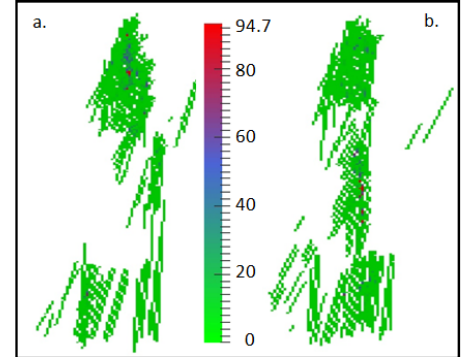
Figure 9. Two vertical slices of the voxel space coloured by absolute differences between amplitude of minimum scan angle and maximum amplitude